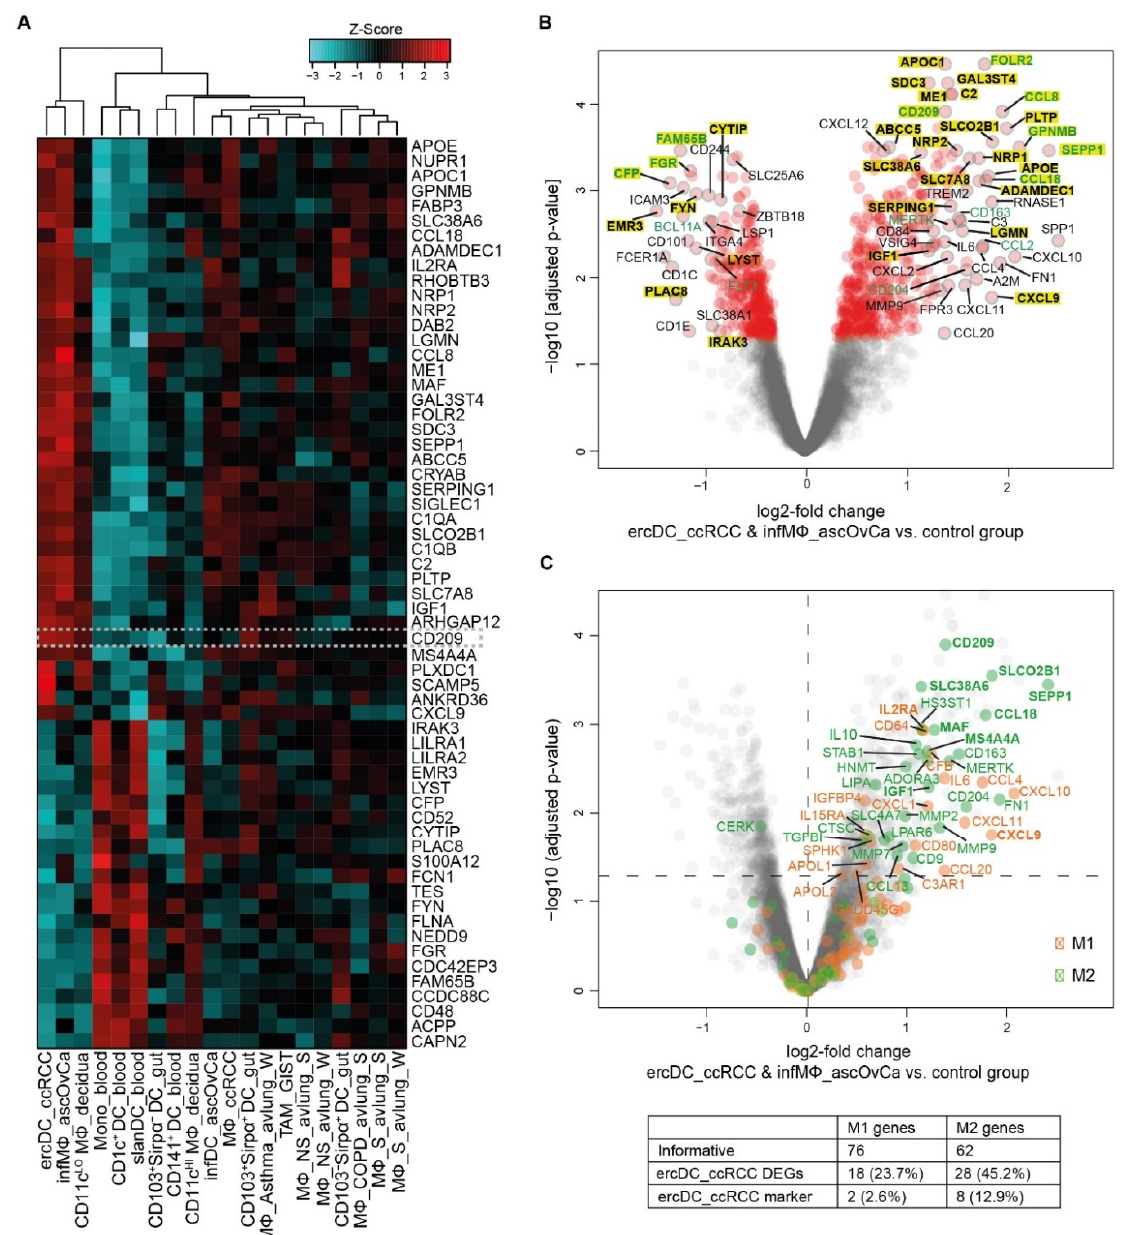
Figure 4. Marker gene profile and DEGs of ercDC_ccRCC. ( A ) Clustered heatmap of relative expres- sion levels of 61 marker genes calculated with NSCM (see also Figure S1C) comparing expression levels of ercDCs_ccRCC with those of the other cell types listed in Table S2 (control group). Dashed box highlights the gene CD209/DC-SIGN, which was used to distinguish ercDC_ccRCC from M Φ _ccRCC in flow cytometry. ( B ) Volcano plot depicting differences in gene expression across informative genes of ercDC_ccRCC&infM Φ _ascOvCa ( n = 11) and control group ( n = 177). DEGs are red symbols (adjusted p < 0.05). Symbols with assigned gene name have a grey edge. ErcDC_ccRCC marker genes are in bold and highlighted in yellow; green: genes discussed in the text. ( C ) Volcano plot depicting M1- and M2-macrophage-associated genes (orange and green); (grey): informative genes resulting from the comparison of ercDC_ccRCC&infM Φ _ascOvca and the control group. DEGs among informative genes are located above the dotted horizontal line ( p < 0.05). The table shows the number and percentage of ercDC_ccRCC&infM Φ _ascOvCa DEGs and marker genes (bold) within the informative M1- and M2-macrophage-associated